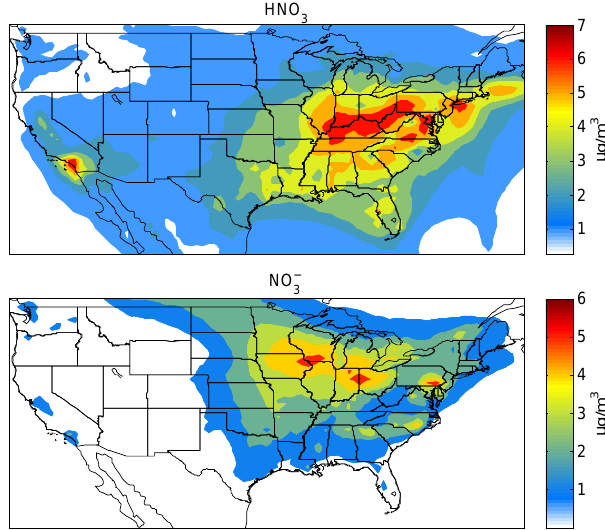
Fig. 9. Predicted 2009 annual mean concentrations of HNO 3 (upper panel) and nitrate aerosol (lower